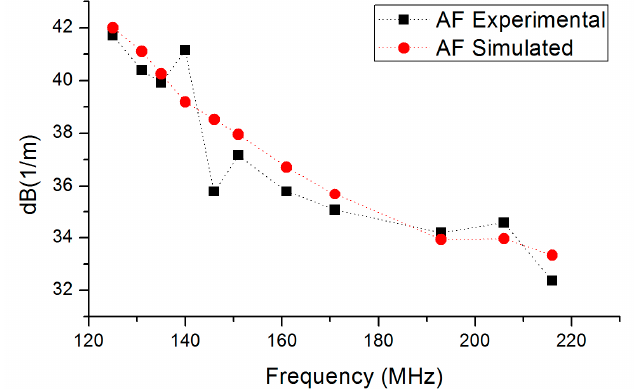
Figure 6. Experimental and simulated antenna factors versus frequency. Connecting lines are referential, to help the